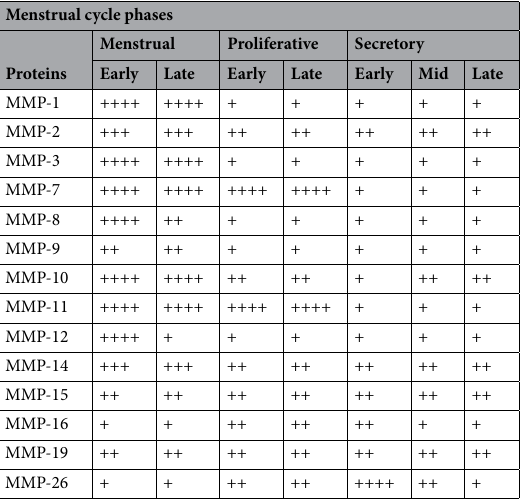
Table 1. Activity of MMPs during reproductive cycle of women; minimal activity: +, moderate activity: ++/+++, strong activity: ++++ 46